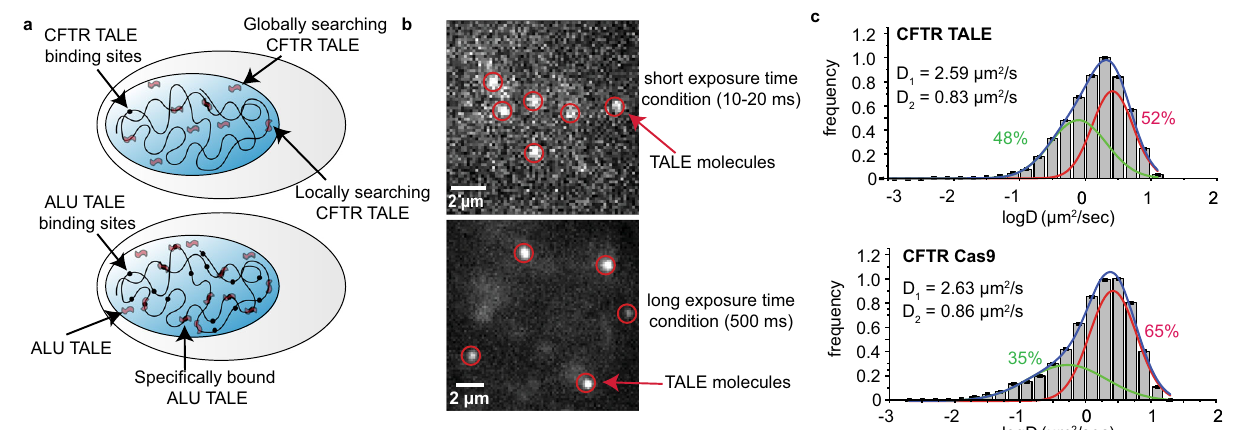
Fig. 1 Single-molecule imaging of TALE target-search dynamics. a Schematic of TALE-Halotag imaging. The difference in density of Alu- and CFTR-TALE binding sites is illustrated. Different modes of target search, i.e., global search and local search, are highlighted with arrows. b Microscope images of short- exposure time (top image) and long-exposure time condition (bottom image) are shown. Red circles denote protein molecules. c Diffusion coef fi cient histograms of TALE and dCas9 proteins targeting the CFTR elements in the human genome. There are two characteristic populations, fast and slow- moving, which are present in the case of both TALE and dCas9. N CFTR TALE = 16,348 and N CFTR Cas9 = 38,395, where N denotes the number of data points. Source data are provided as a Source Data fi le.